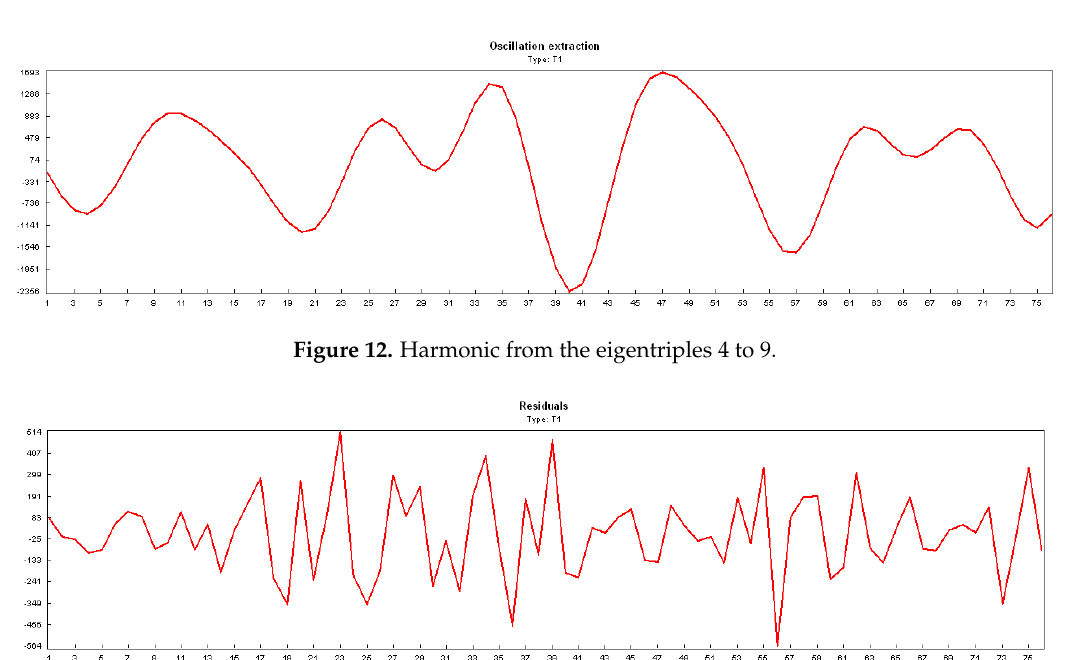
Figure 11. Reconstructed trend from the eigentriples 1 to 9.compared with ACWP and S-Curve